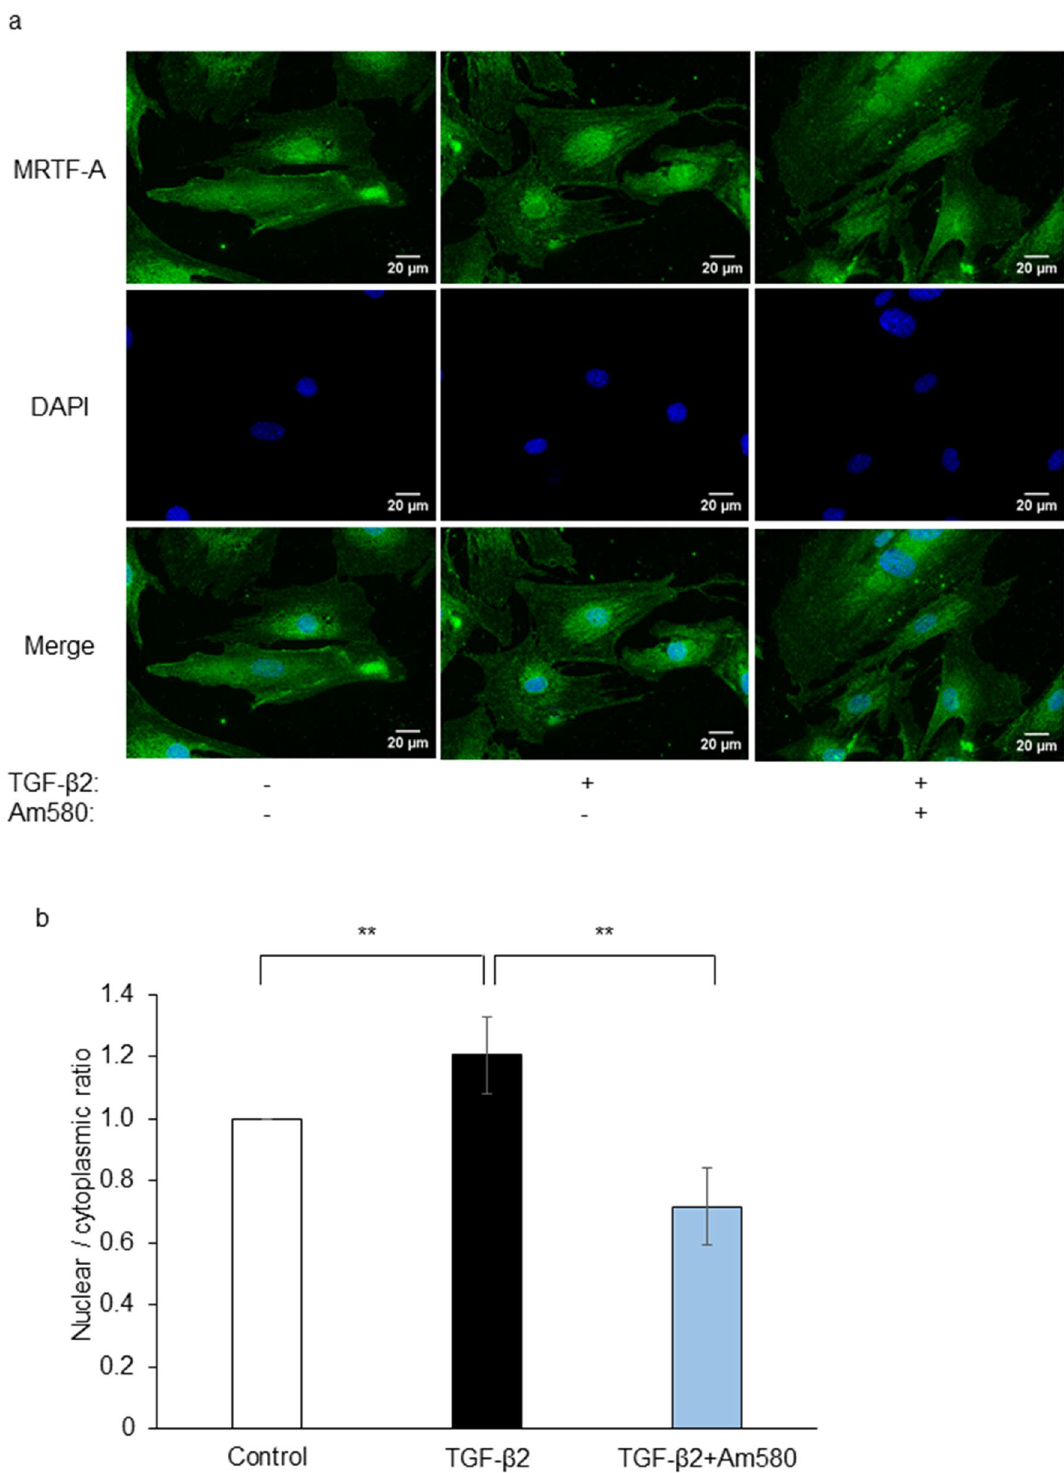
Figure 7. Inhibitory effect of an RAR-α agonist on TGF-β2-induced nuclear translocation of MRTF-A in RPE cells. ( a ) Serum-deprived RPE cells cultured on cover glasses in 24-well plates were incubated with or without Am580 (10 µM) for 12 h and then in the additional absence or presence of TGF-β2 (10 ng/ml) for 24 h, after which they were fixed and subjected to immunofluorescence analysis of MRTF-A (green). Nuclei were stained with DAPI (blue). Scale bars, 20 µm. Data are representative of four independent experiments. ( b ) The nuclear/cytoplasmic ratio of MRTF-A immunofluorescence intensity in experiments as in ( a ) was determined and expressed relative to that for control cells. Data are means ± s.d. for a total of 20 cells in four independent experiments. The intensity of MRTF-A immunofluorescence in the nucleus and cytoplasm was measured with the use of the ROI manager commands in ImageJ software. ** P < 0.01 (Dunnett’s